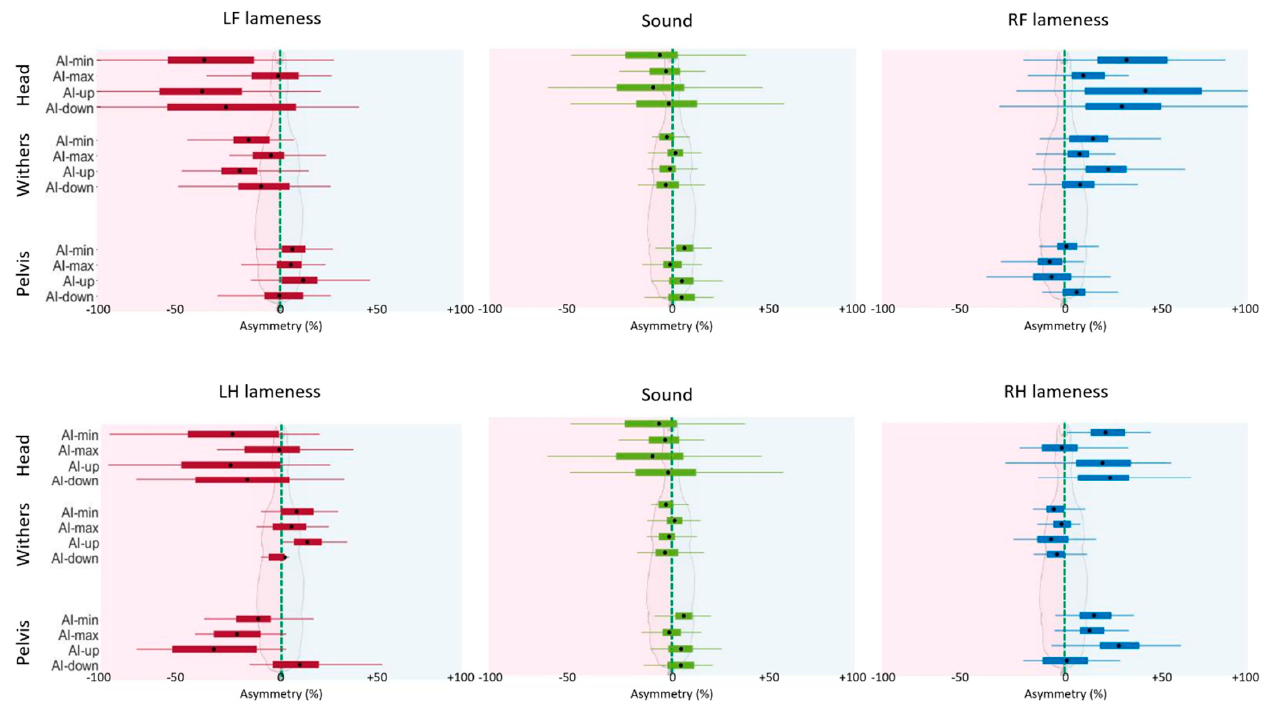
AI 1 —asymmetry indice, RF 2 —right forelimb, LF 3 —left forelimb, RH 4 —right hindlimb, LH 5 —left hindlimb.